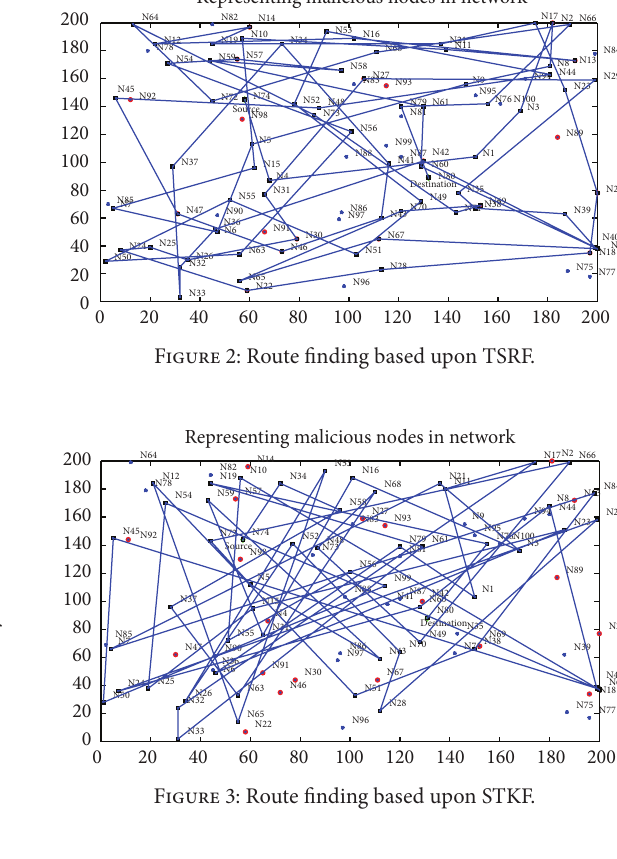
Table 1: Simulation